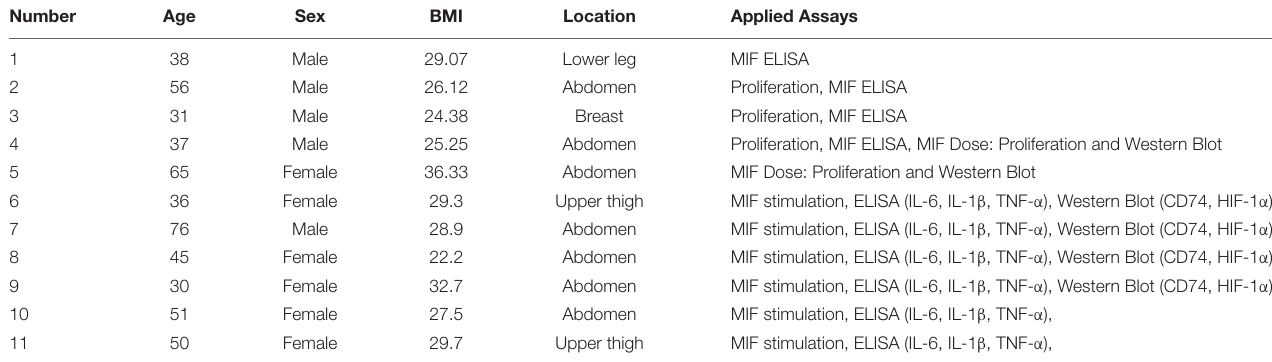
TABLE 1 | Details of healthy adipose tissue samples in group A.